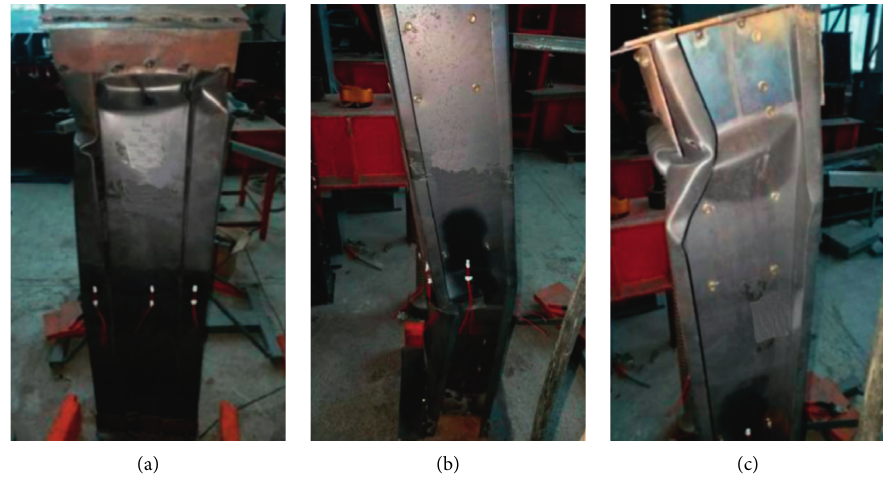
Figure 16: 4C-3 failure mode: (a) south, (b) east, and (c) west.